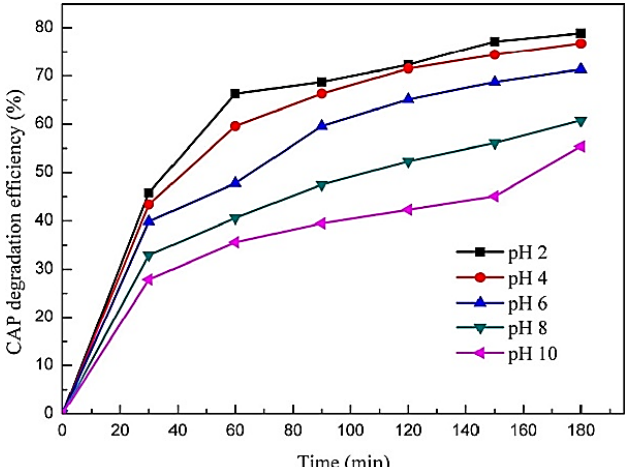
Figure 7. Effect of initial pH of wastewater on the chloramphenicol degradation efficiency of particle electrodes. Reprinted from Sun et al. [107], copyright © (2017) with permission from Elsevier.